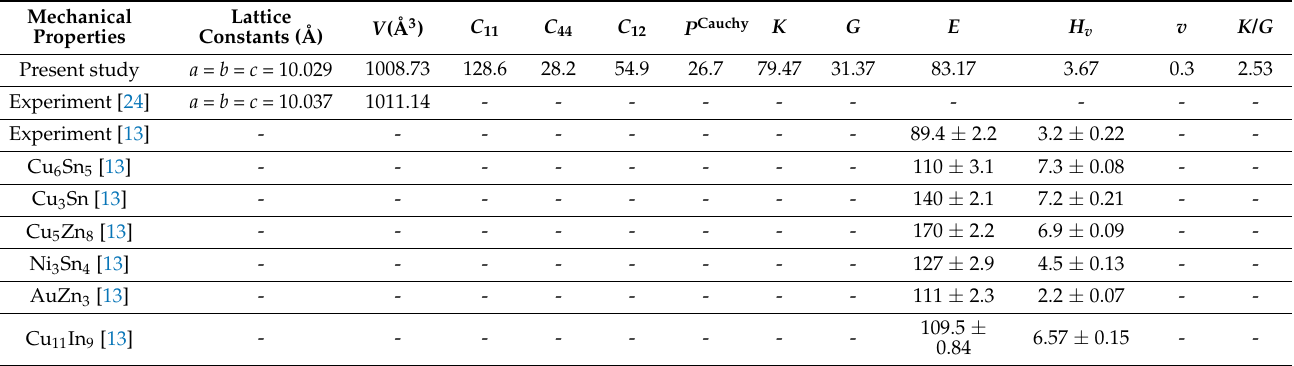
Table 3. Calculated lattice constants, equilibrium volume V , elastic coefficients, Cauchy pressure (GPa), bulk modulus K (GPa), shear modulus G (GPa), Young’s modulus E (GPa), hardness H v (GPa), Poisson’s ratio v , and ratio of bulk modulus to shear modulus K/G of the Ag 9 In 4 crystal, together with comparison with the other seven IMC systems in terms of E and H v